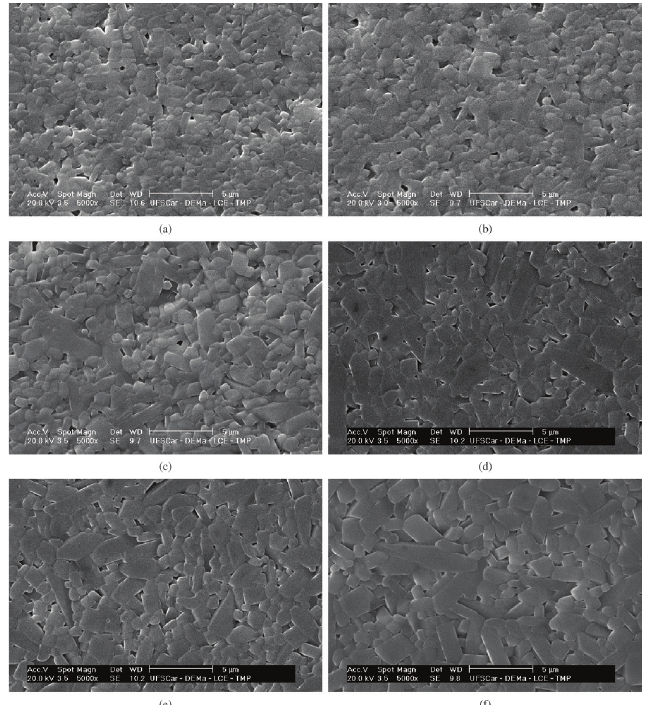
Figure 7. SEM micrographs of La at 1600 °C/2h (d) 0.5L, (e) 1L, (f)